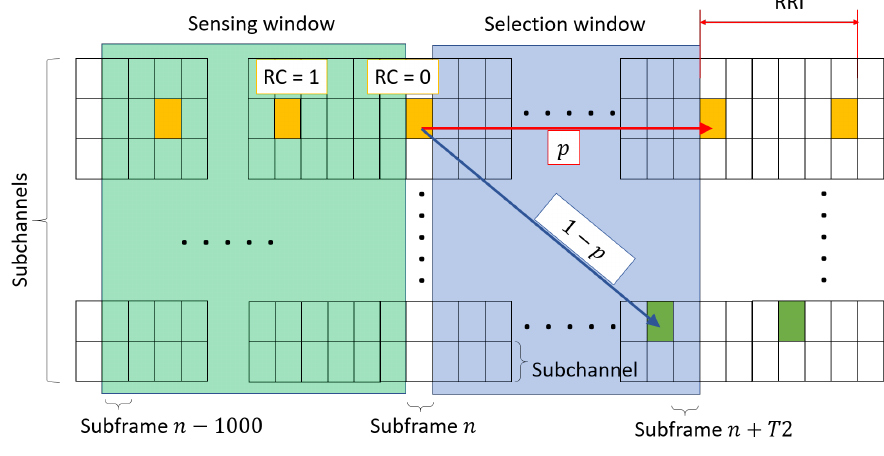
Figure 1. Reselection in SPS; p is the resource keeping